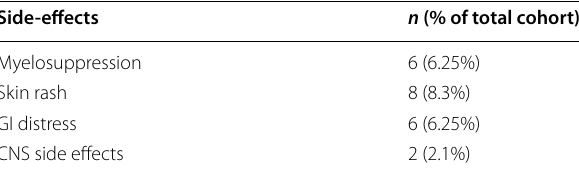
Table 5 Table showing the frequency of side-effects and their percentage (of the total cohort) reported in children who were on different regimens of